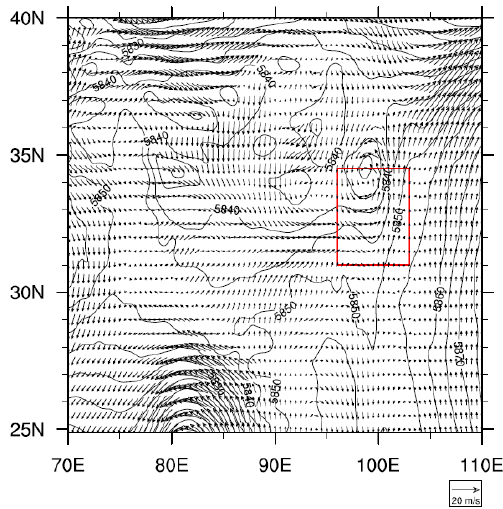
Figure 8. Geopotential height fields (units: m) and horizontal wind (units: m·s −1 ) at 12 UTC on 5 August 2014 at 500 hPa. The red box is the precipitation area.